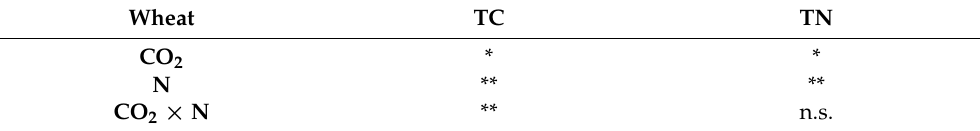
Table 6. Two-factor ANOVA analyses for indices in the root exudate of wheat. Wheat TC TN CO 2